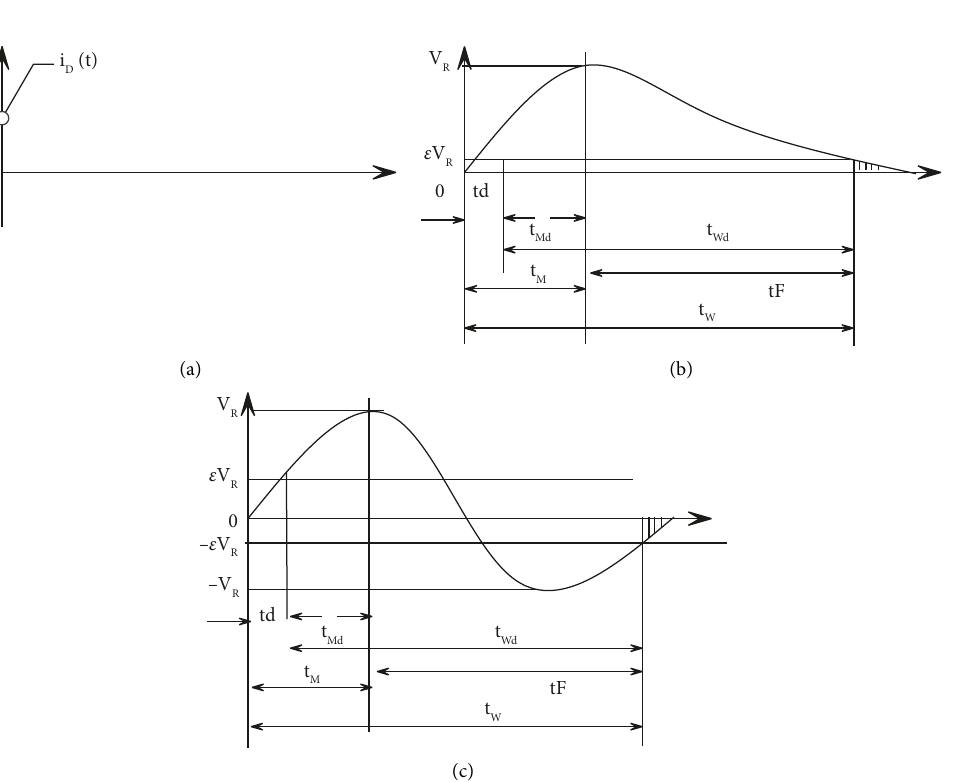
Figure 2: Second-order active